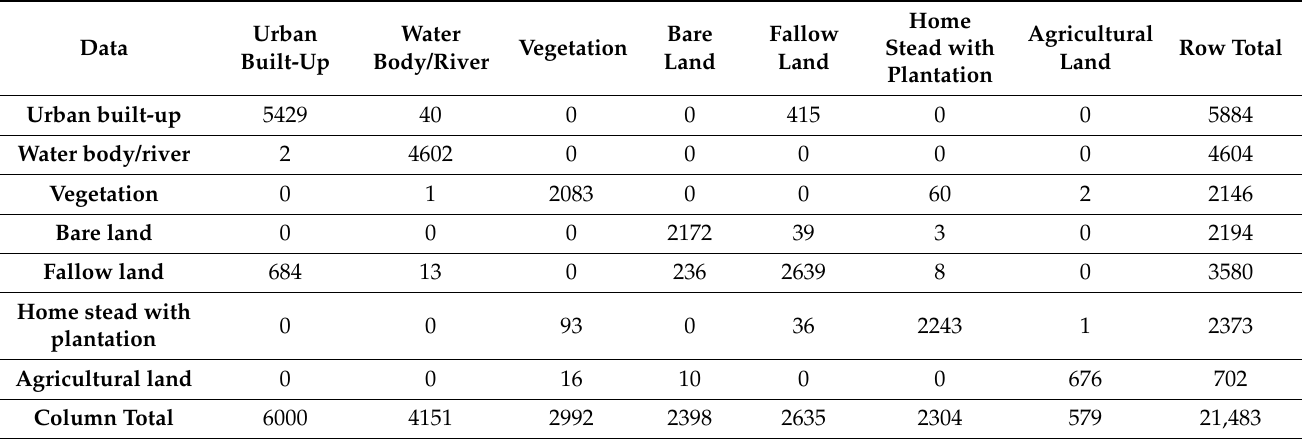
Table 3. Contingency matrix for land use and land cover, 1999.